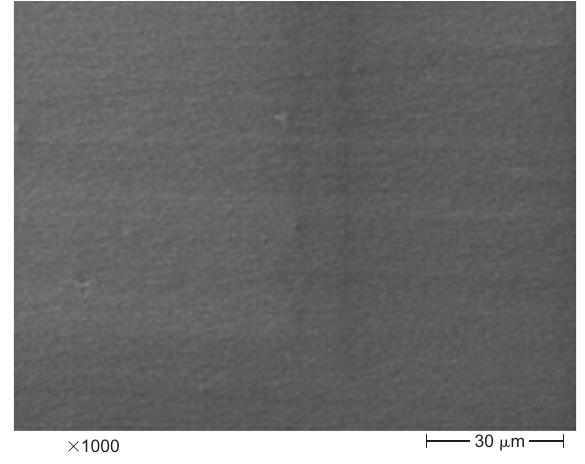
Figure 2 SEM picture from fracture surface of neat RTM6 ® .